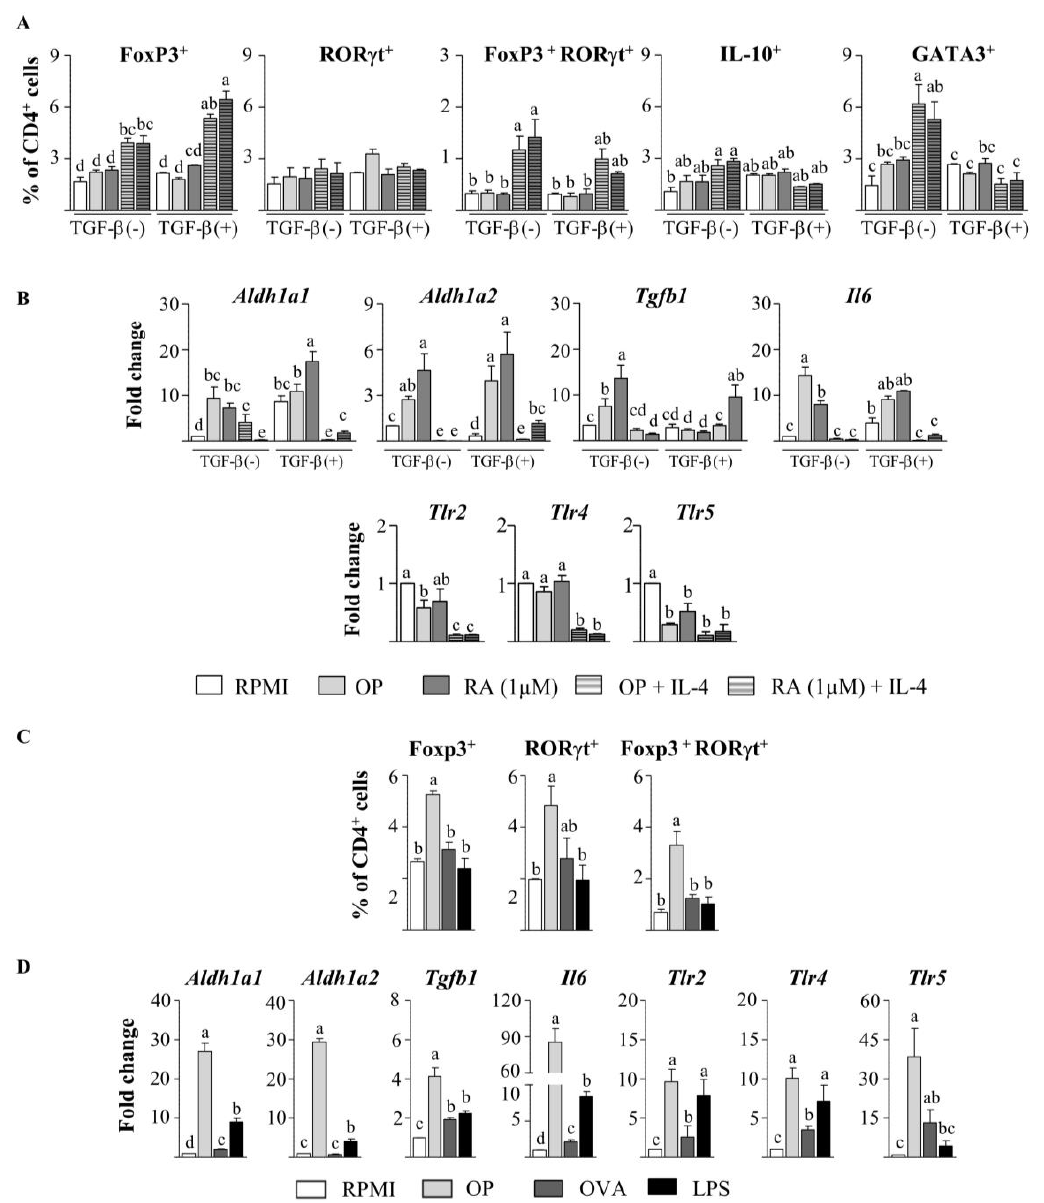
Figure 5. OP enhances Foxp3 + cells and Foxp3 + RORγ + cells in culture with CD4 + T cells from EW-sensitised mice.( A )and( B )Spleen CD4 + T cells from naïve mice were cultured without stimuli (RPMI), or with OP, RA, OP+IL-4, or RA+IL-4 for 2 days, in the absence or presence of TGF-β, followed by stimulation with anti-CD3 and anti-CD28 for 2 additional days.The percentage of Foxp3 + , RORγ + , Foxp3 + RORγ + , IL-10 + , and GATA3 + cellswithin the total CD4 + T cell population was assayed by flow cytometry ( A ), and gene expression of Aldh1a1, Aldh1a2, Tgfb1, Il6, Tlr2, Tlr4, and Tlr5 was assayed by qPCR, normalised to the reference gene Actb , and expressed relative to CD4 + T cells cultured in RPMI ( B ). ( C )and( D )Spleen CD4 + T cells from EW-sensitised mice were cultured without stimuli (RPMI) or with OP, OVA, or LPS for 2 days, followed by stimulation with anti-CD3 and anti-CD28 for 2 additional days.The percentage of Foxp3 + , RORγ + , and Foxp3 + RORγ + cellswithin the total CD4 + T cell population was assayed by flow cytometry( C ), and gene expression of Aldh1a1, Aldh1a2, Tgfb1, Il6, Tlr2, Tlr4, and Tlr5 was assayed by qPCR, normalised to the reference gene Actb , and expressed relative to CD4 + T cells cultured in RPMI ( D ). Results of an experiment representative of 3 separate experiments performed in triplicate are shown. Data are means ± SEM. Different letters indicate statistically significant differences ( p < 0.05) calculated using one-way ANOVA, followed by Tukey’s post-hoc test ( A and C ) or the Mann–Whitney U test ( B and D ).